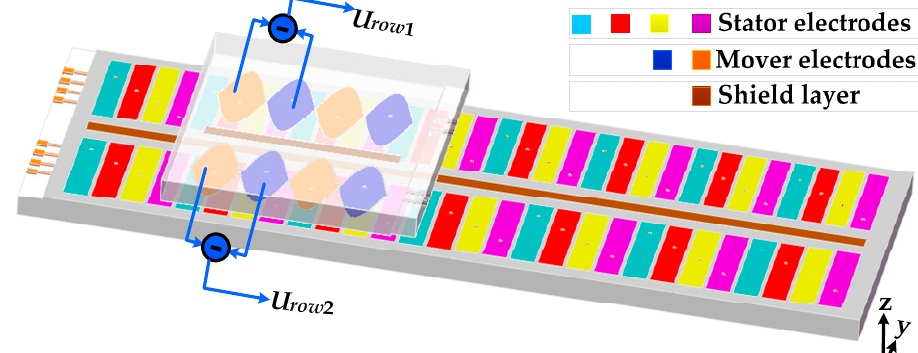
Figure 7. Schematic diagram illustrating the optimized structure of the VATG sensor, which includes increasing the distance between the two rows and adding a shielding layer between them to reduce the influence of signal crosstalk. In addition, a differential induction structure is adopted to reduce common mode disturbance.